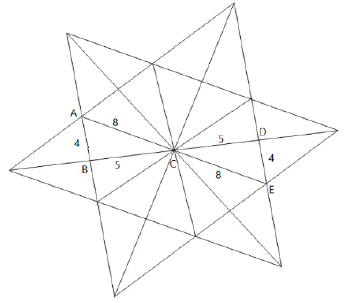
Figure 7. The seventh ornamentation.